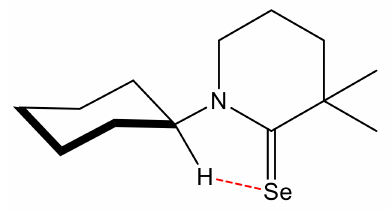
Figure 6. The intramolecular Se-H interaction observed in the CAAC-selenium